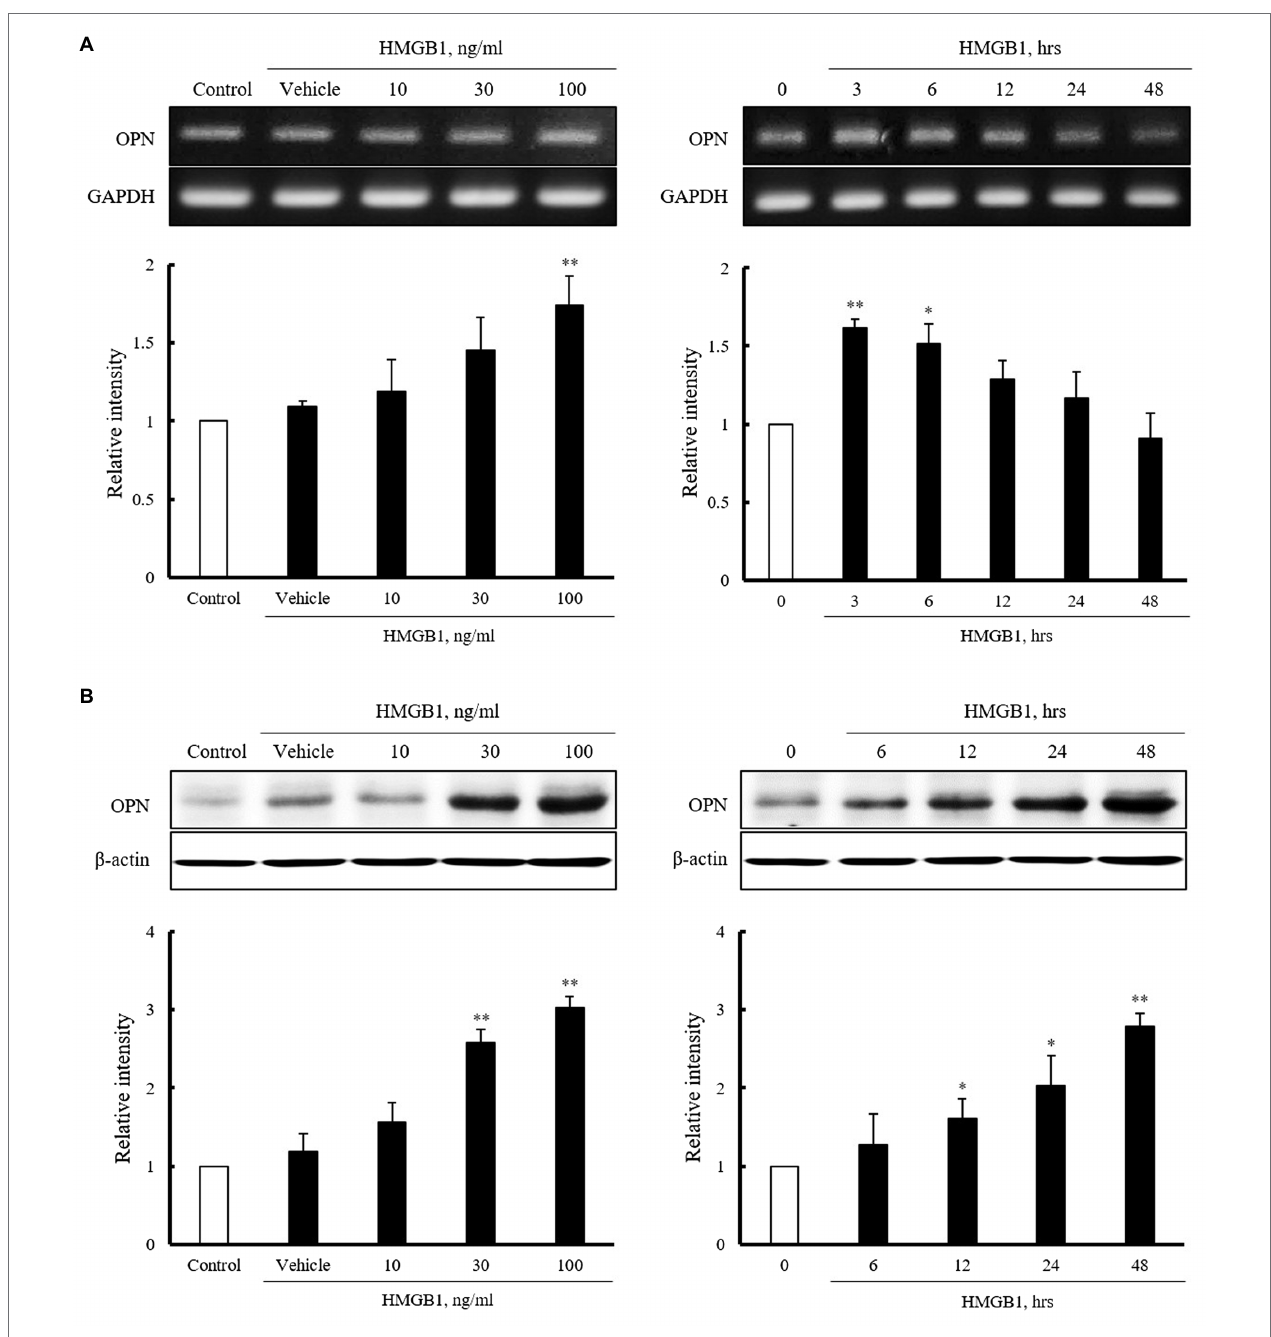
FIGURE 2 | Characteristics of OPN mRNA and protein expression in VSMCs stimulated with HMGB1. (A) VSMCs were treated with HMGB1 (10 to 100 ng/ml) for 3 h or 100 ng/ml of HMGB1 for 0 to 48 h, and then, mRNA levels of OPN were determined by RT-PCR. GAPDH was used as a control. Relative intensities were expressed as the mean ± SEM of 3–4 independent experiments. * p < 0.05 and ** p < 0.01 vs. corresponding value in control or 0 h. (B) VSMCs were stimulated with HMGB1 (10 to 100 ng/ml) for 48 h or 100 ng/ml of HMGB1 for 0 to 48 h, and then, protein levels of OPN were determined by Western blot. β -actin was used as a control. Relative intensities were expressed as the mean ± SEM of 4–6 independent experiments. * p < 0.05 and ** p < 0.01 vs. corresponding value in control or 0